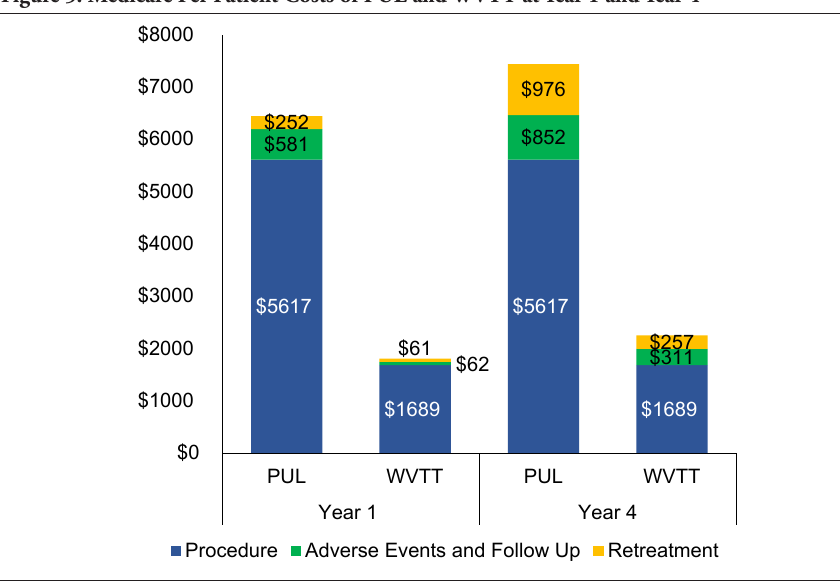
Figure 5. Medicare Per Patient Costs of PUL and WVTT at Year 1 and Year